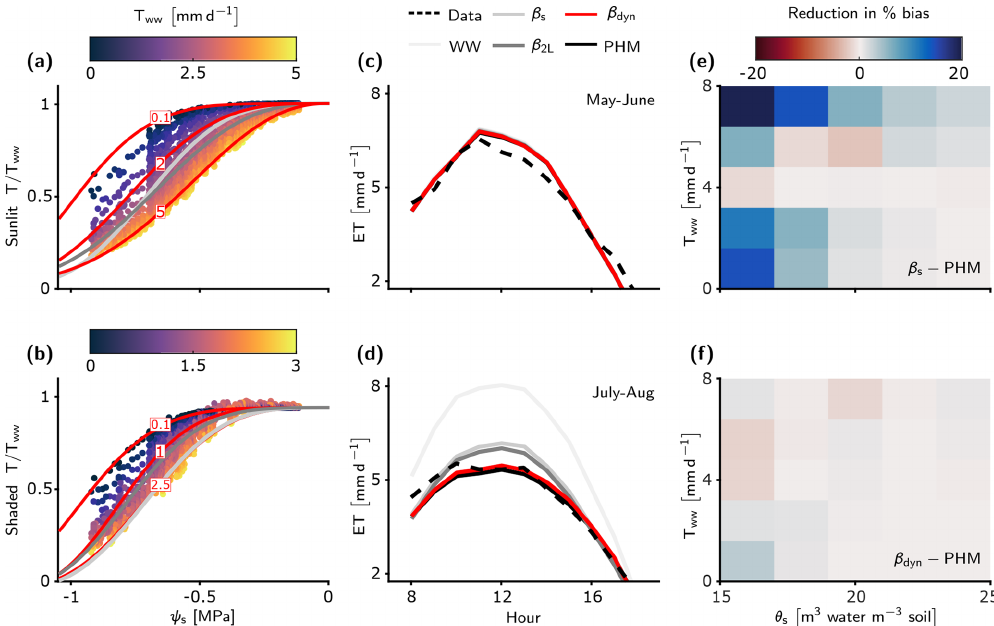
Figure 5. LSM evapotranspiration estimates improved by PHM and new dynamic β . (a–b) Fits of the β s , β 2L , and β dyn schemes to the relative transpiration outputs from the calibrated PHM scheme for the sunlit ( a ) and shaded big leaf (b) of the LSM (see Methods section). Note that only three of the infinite family of β dyn curves are shown for illustration – each corresponding to a fixed T ww value in mmd − 1 (red numbers). Full fitting details of these three schemes are available in Sect. S6.2. (c–d) The median diurnal ET estimates for the LSM with five transpiration downregulation schemes compared to observations at the US-Me2 AmeriFlux site for early (c) and late summer (d) . The dual-source two-big-leaf LSM calculates ET as the sum of sunlit and shaded big-leaf transpiration and ground evaporation. Note that β dyn (red) is overlying PHM (black) results as they are essentially the same. (e–f) Reduction in absolute percent bias of ET between the β s and PHM schemes (e) and β dyn and PHM schemes (f) in terms of atmospheric moisture demand (represented by T ww ) and soil water status (represented by θ s ). In both plots, blue indicates PHM improvement over the selected β